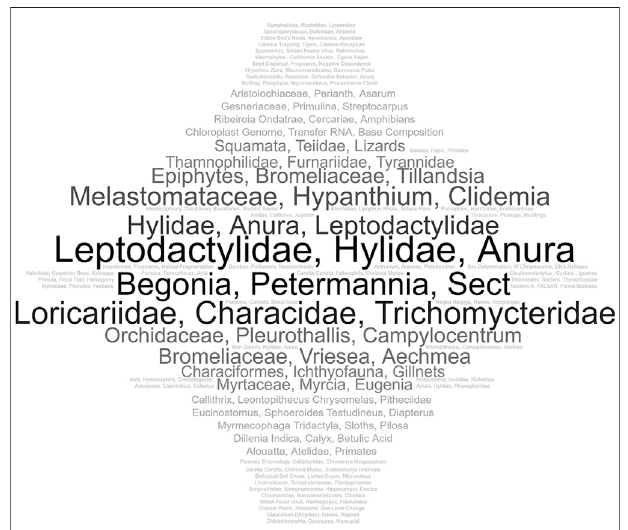
FIGURE 1 | Cloud of topics of higher incidence and high prominence of the analyzed institutional production (1993 – 2019).